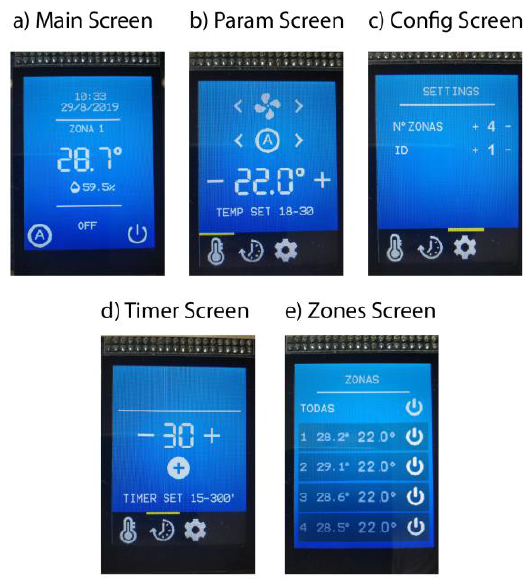
Figure 5. Screens designed for the user interaction: ( a ) Main screen, ( b ) Param screen, ( c ) Config screen, ( d ) Timer screen, and ( e ) Zones screen.